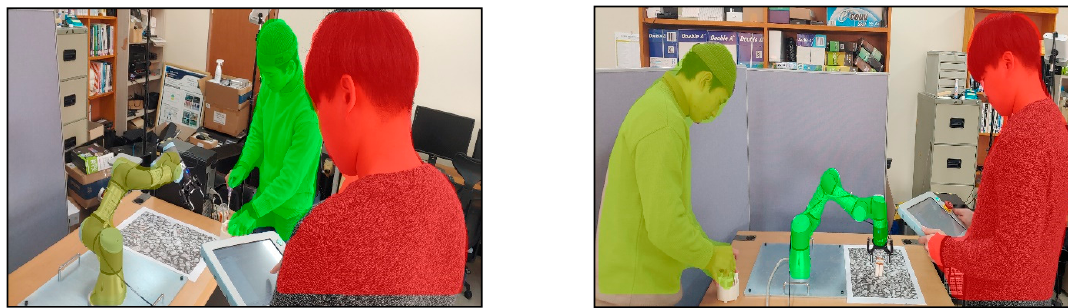
Figure 8. 3D spatial relation among segmented instances.